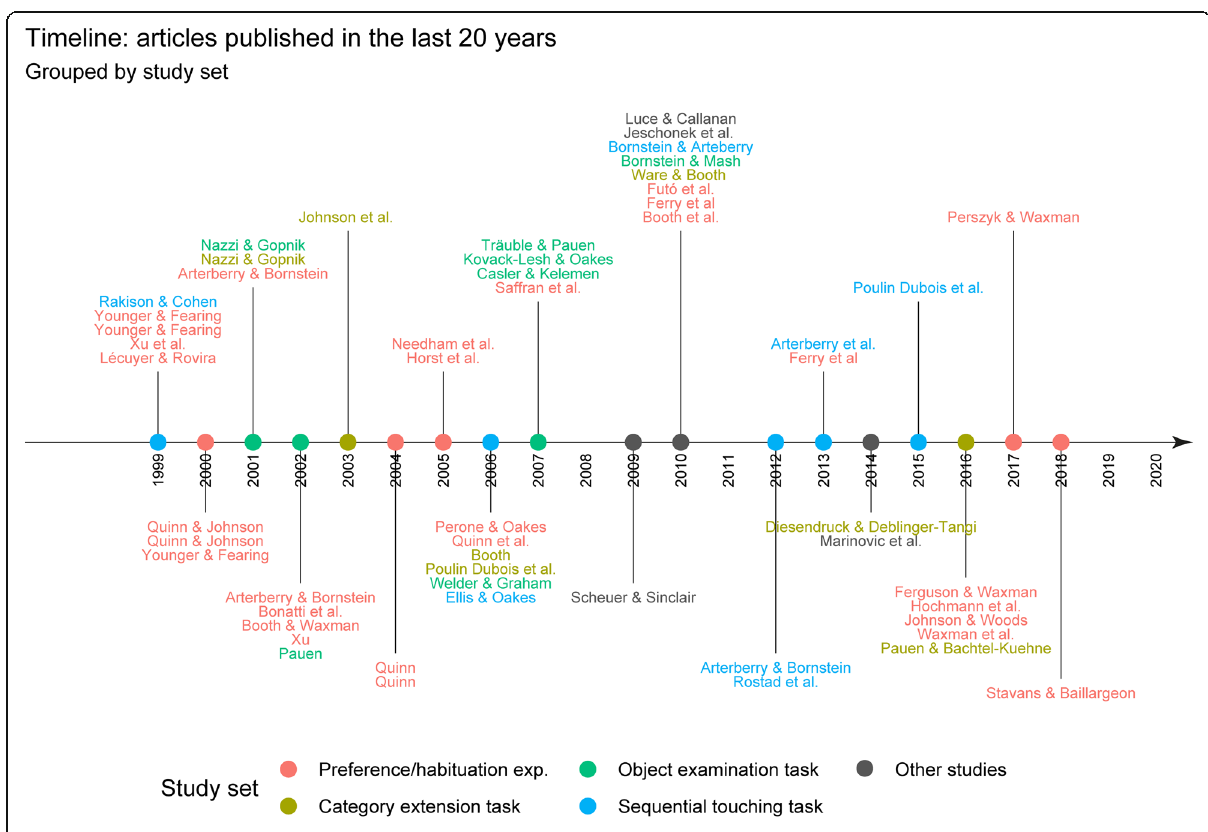
Fig. 2 Timeline: articles published in the last 20 years. Grouped by study